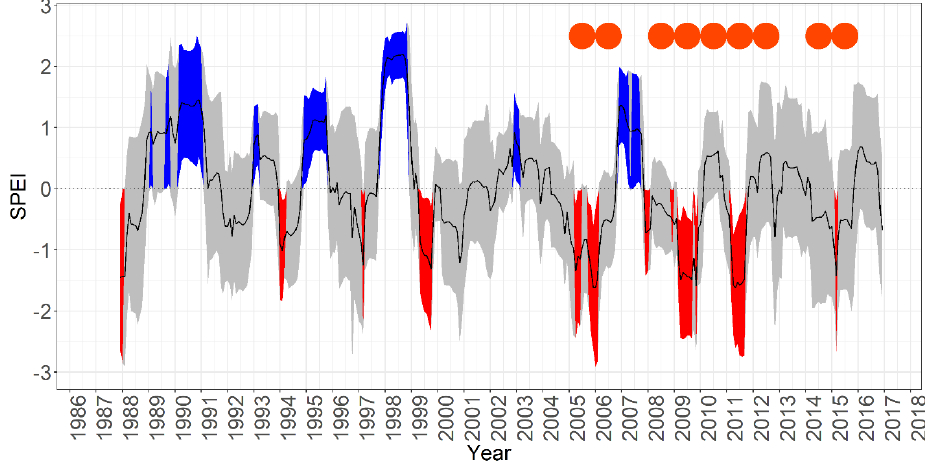
Figure 8. Inter-product SPEI mean (black line) ± 2 standard deviations (gray shading), compared with key informant information from 2005 to 2016 (Red dots). Periods where mean SPEI ± 2 standard deviations were below zero are colored red, those above zero are blue.